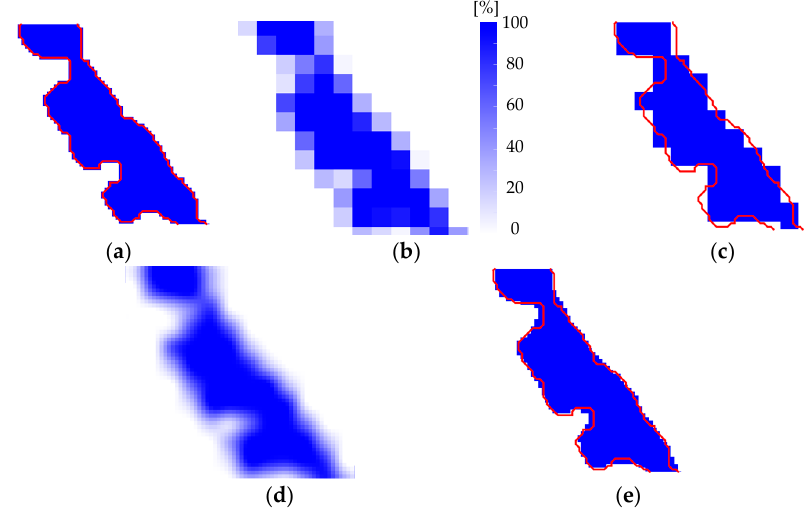
Figure 16. Interpolation-based SRM using semi-simulated water fractions: ( a ) reference map, ( b ) semi-simulated water fractions ( ZF = 5), ( c ) hard classifed map, ( d ) bicubic interpolation of water fractions, and ( e ) sub-pixel map; reference river boundaries are represented by red lines on each map. User and producer accuracies of the river area extracted from the hard classification and SRM of semi-simulated fractions are presented in Figures 17 and 18 for the Sarca and Noce rivers, respectively.